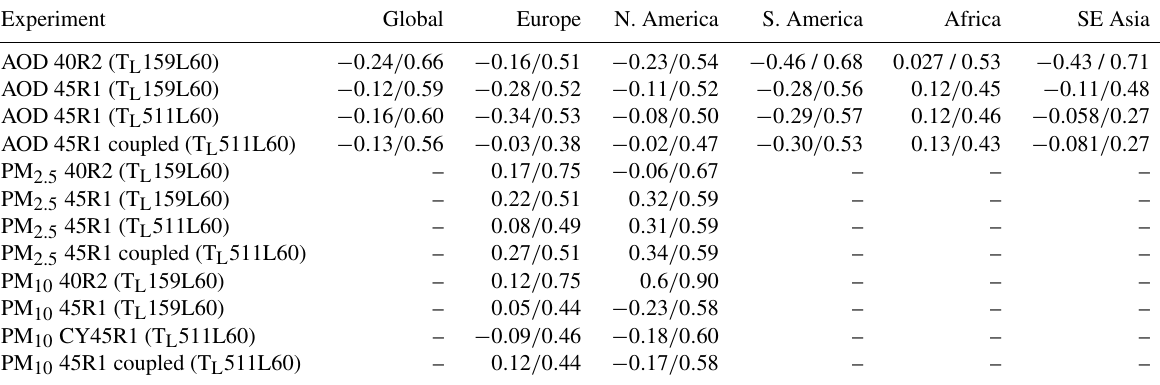
Table 13. Average over 1 May 2016 to 1 May 2017 of the modified normalized mean bias (MNMB) / fractional gross error (FGE) of daily AOD at 500nm and PM from the experiments described in this section. AOD observations are from AERONET level 2; European PM observations are from 65 PM 2 . 5 and 138 PM 10 background rural AirBase stations; North American PM observations are from 1006 PM 2 . 5 stations and 336 PM 10